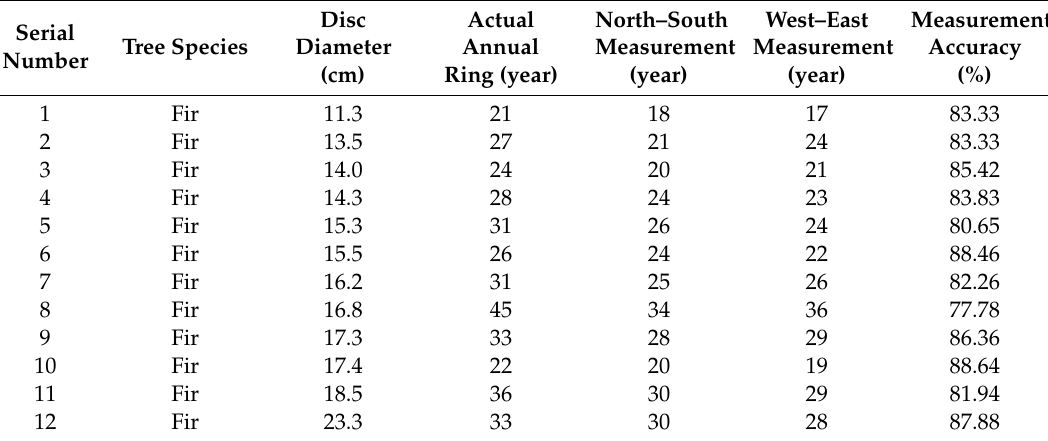
Table 2. The measurement results of